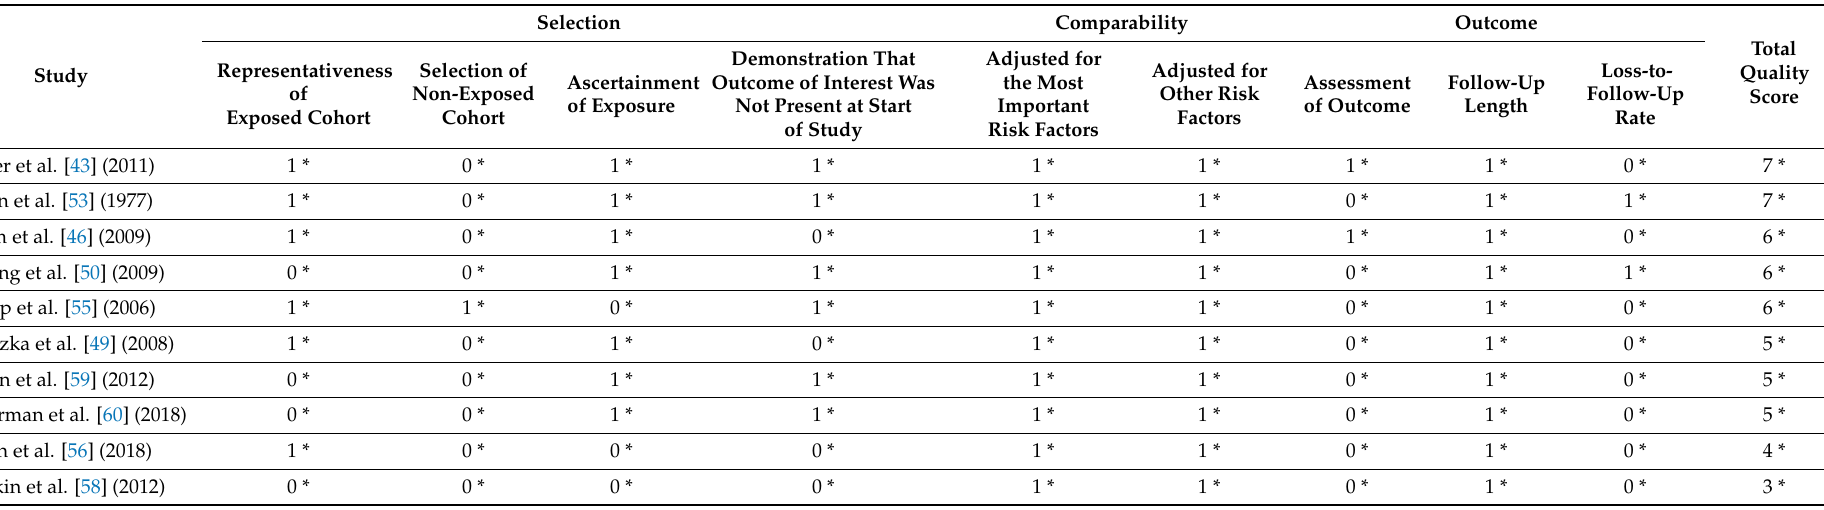
Table 2. Methodological quality of the cohort studies.